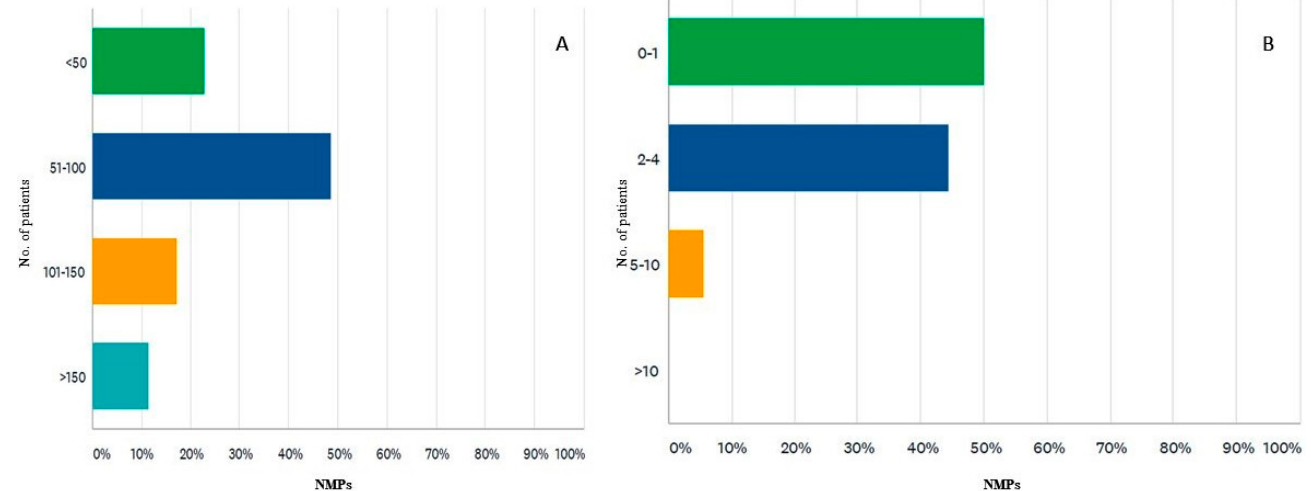
Figure 1. ( A ) Number of patients investigated by scintigraphy for all indications, routinely each month by nuclear medicine physicians. ( B ) Number of patients referred each month for bisphos- phonate scan and investigated by nuclear medicine physicians involved in the diagnosis of CA.